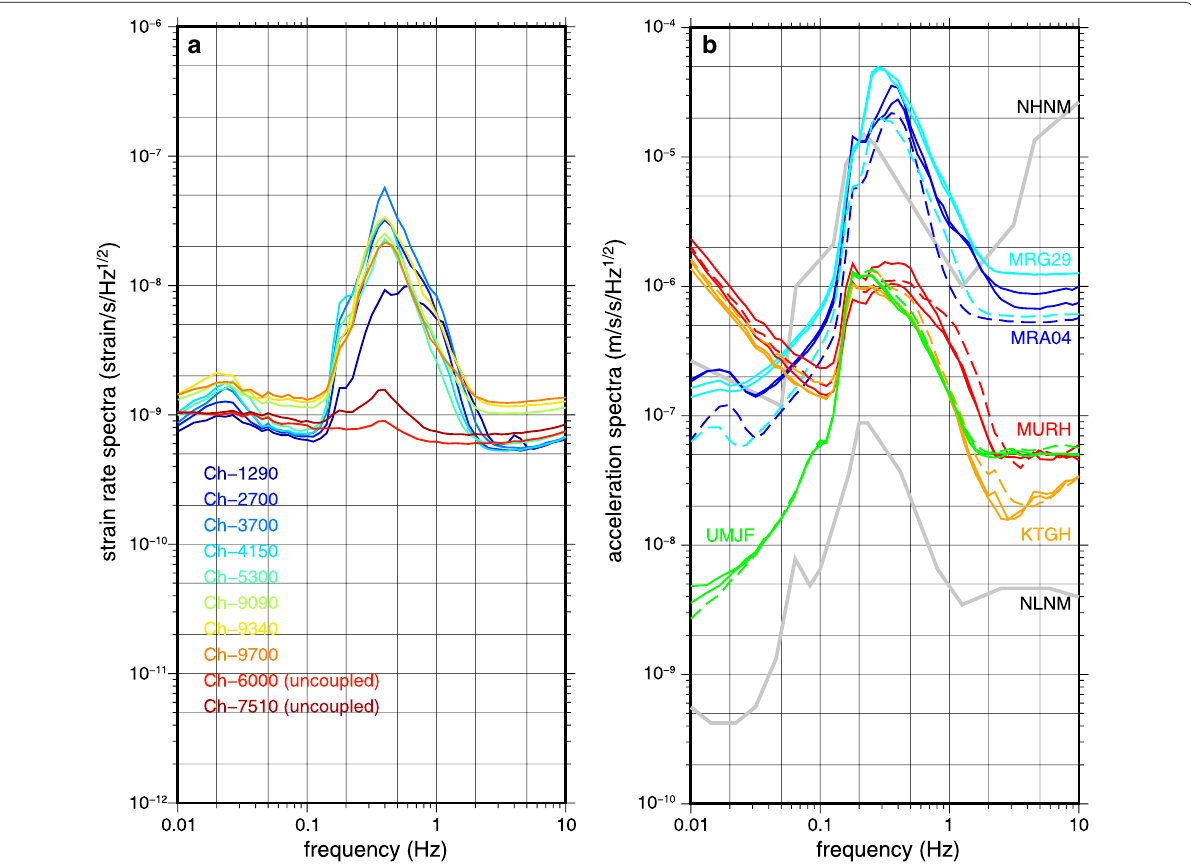
Fig. 3 Comparison of the noise levels between the DAS and nearby seismometers. a Strain rate spectra at ten selected channels. Each line shows the median value of the periodograms calculated at 5-min intervals for the entire observation period (January 27–31, 2020 (JST)), which were computed at 5-min intervals during the entire observation period (Figure S1). b Acceleration spectra at five seismic stations. Solid and dashed lines are for the vertical- and horizontal-component seismometers, respectively. Bold gray lines show a standard noise model (Peterson 1993). MRA04 and MRG29 are DONET2 stations, and UMJF is a F-net station; each of these stations has a broadband sensor. We corrected the instrumental response for the MURH and KTGH spectra, which are Hi-net